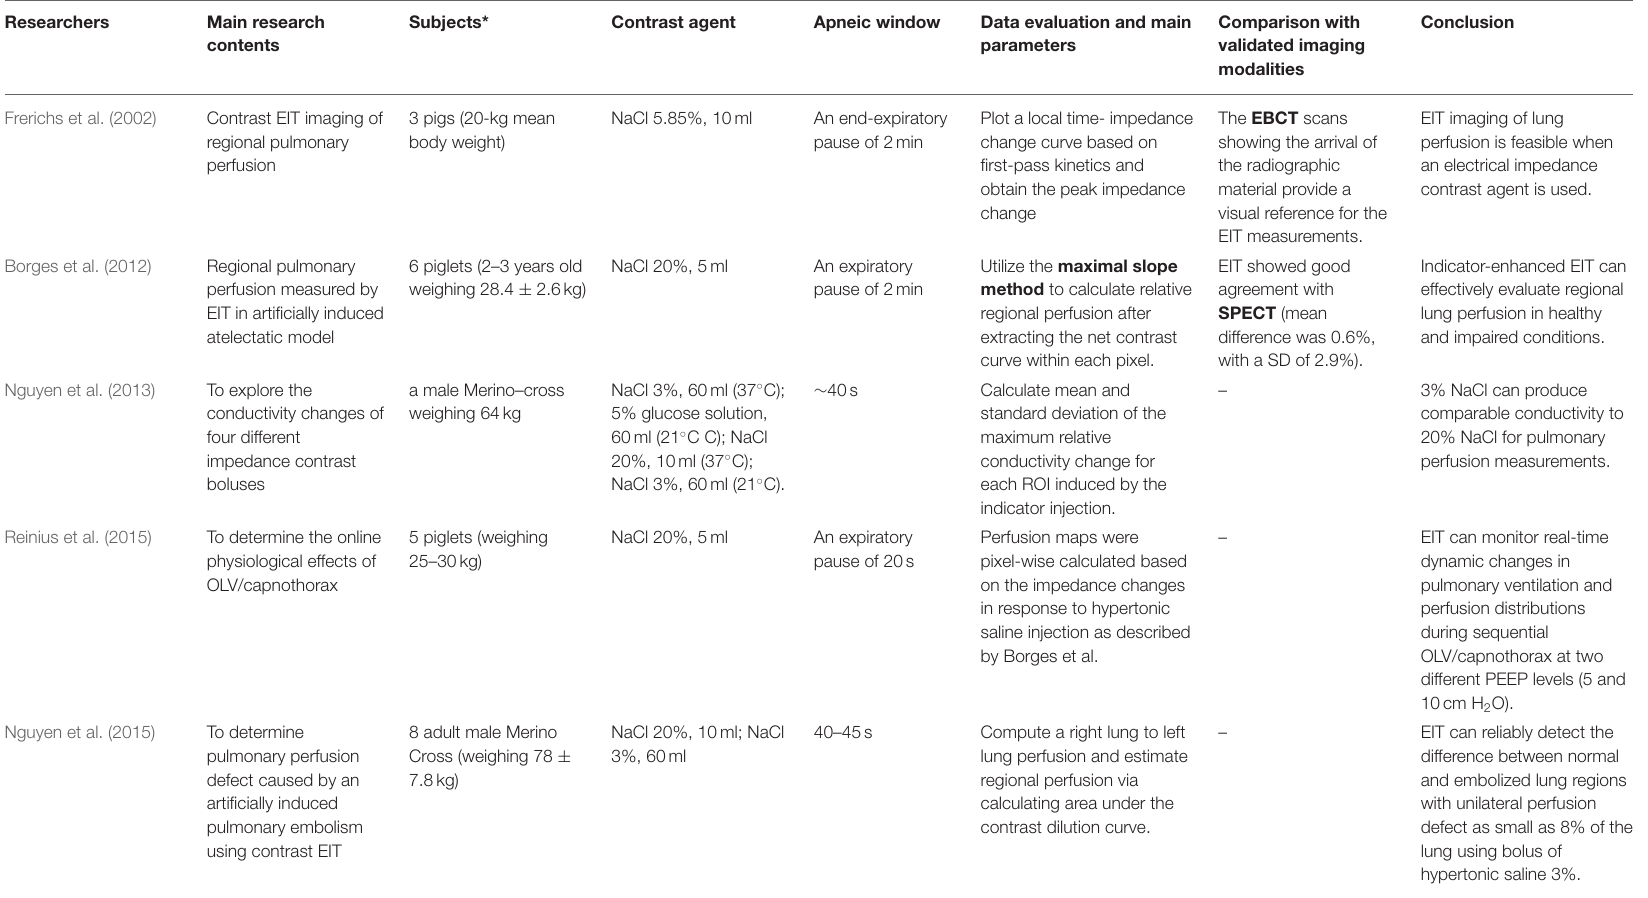
TABLE 2 | Summary on indicator-enhanced EIT in 12 experimental